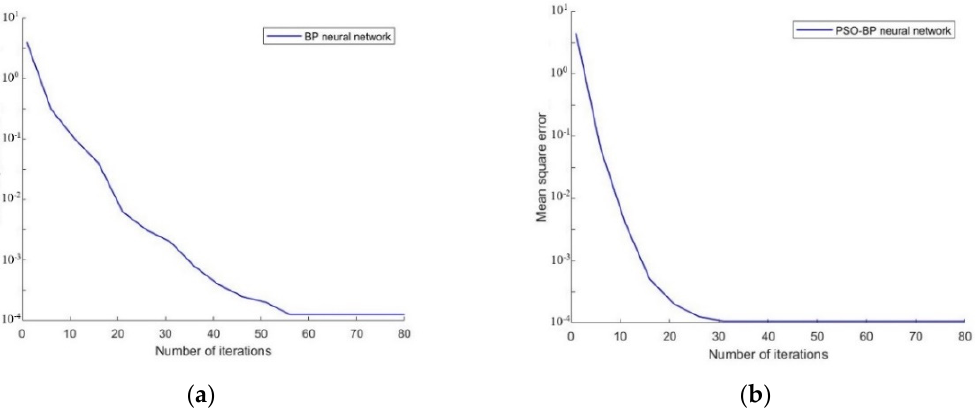
Figure 9. Iterative optimization curve: ( a ) BP neural network; ( b ) GOFF − BP neural network.